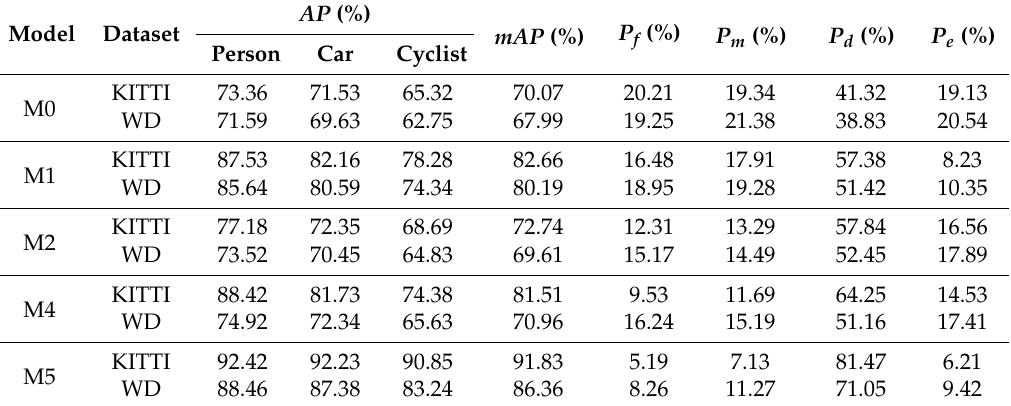
Table 1. Comparison of each model identification and detection